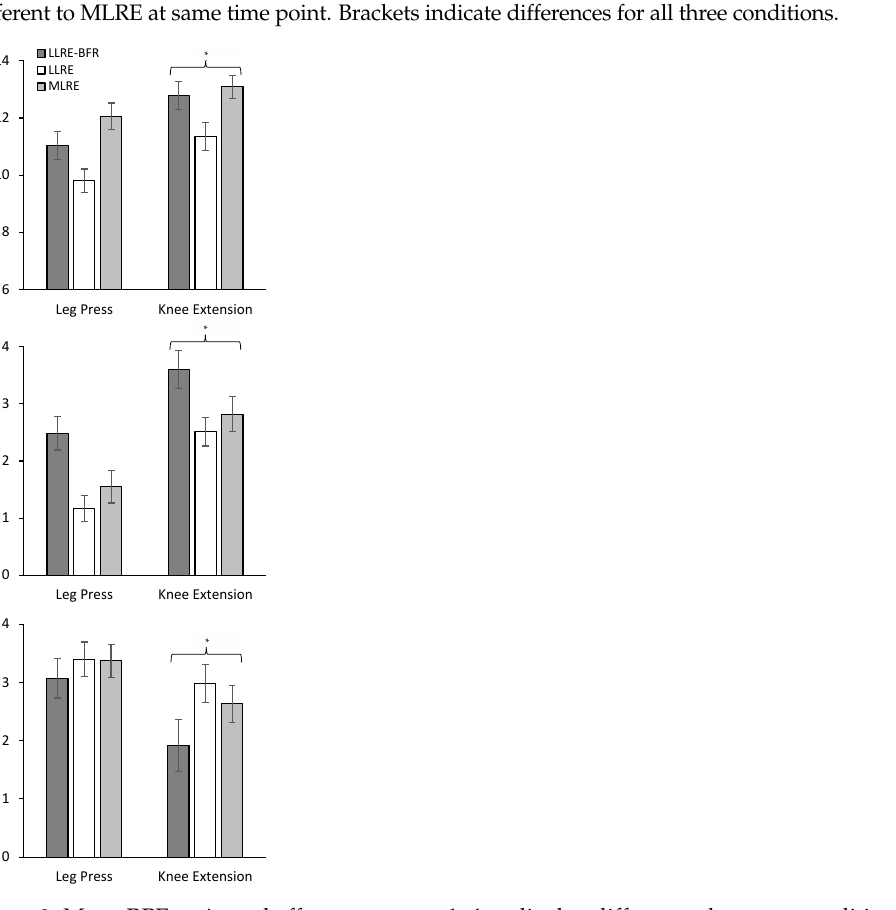
Figure 1. RPE, pain and affect for each exercise and immediately following each set. a Significant difference between pre and set 1; b significant difference between set 1 and set 4; ¥ significantly different to LLRE-BFR at same time point; ‡ significantly different to LLRE at same time point; † significantly different to MLRE at same time point. Brackets indicate differences for all three conditions.